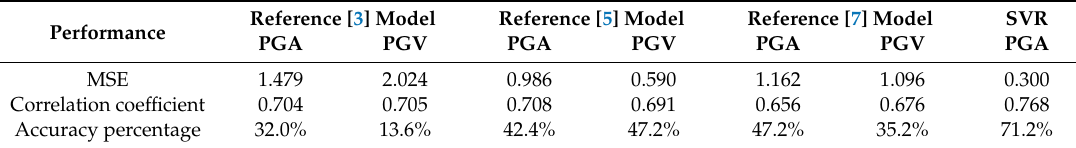
Table 3. Performance measures for nonlinear SVR and linear regressions based on PGA and PGV.